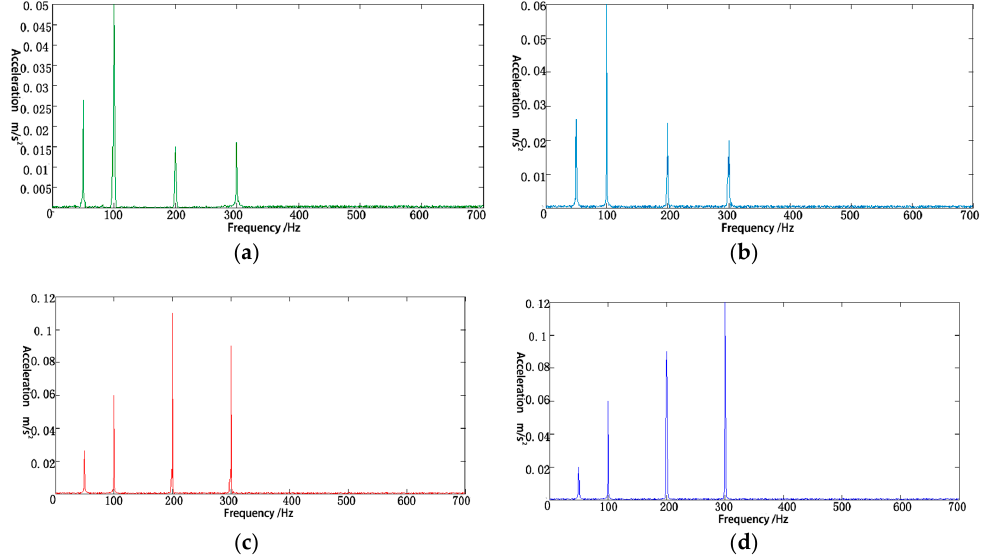
Figure 17. Spectrum diagram of vibration signal at measurement point 1 under different working conditions: ( a ) normal condition; ( b ) insulation shedding; ( c ) winding loosening; ( d ) winding deformation.